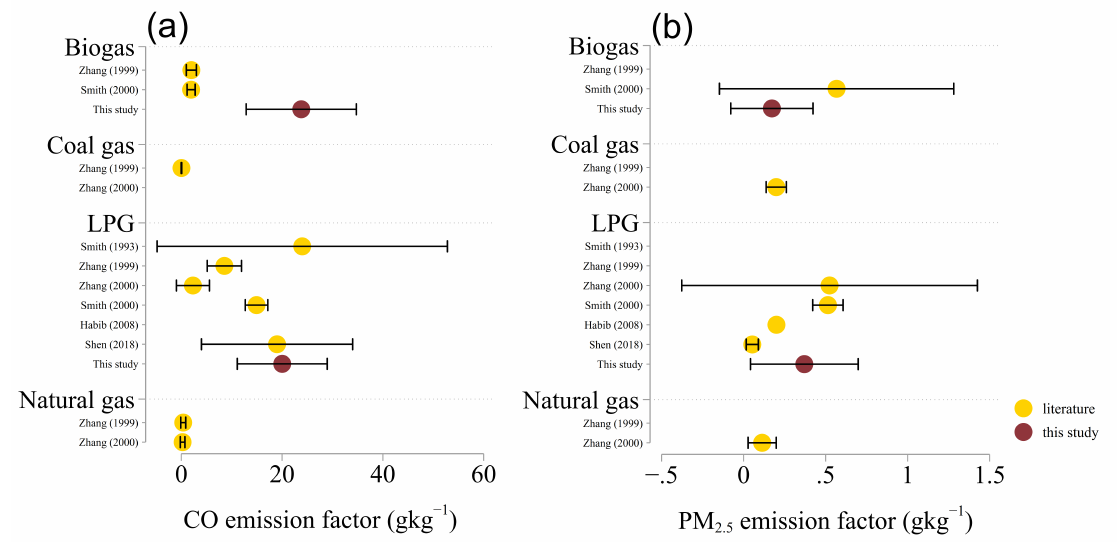
Figure 3. Previous measurements of gas stove emission factors for carbon monoxide ( a ) and fine particulate matter ( b ) on a fuel mass basis [14,15,22,24,25,30]. The points represent the mean and the bars extend plus/minus one standard